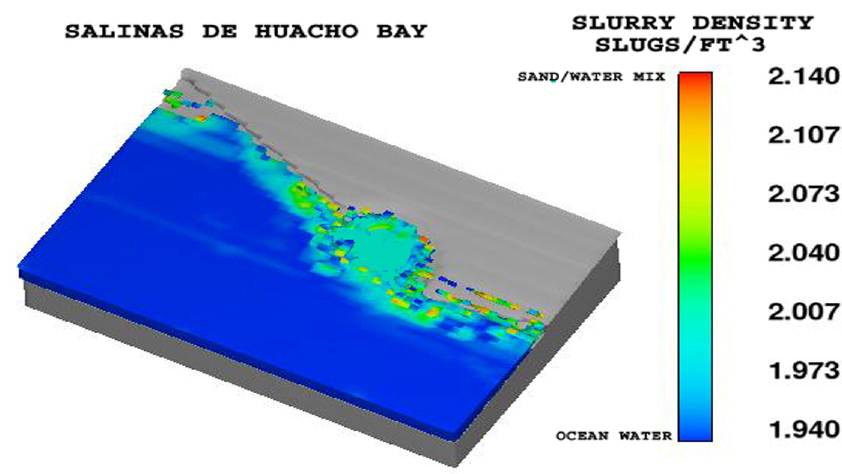
Figure 26. Later El Niño flood events creating a deposition sediment area behind an established beach ridge; the infilling phenomenon infills bays and creates marsh areas behind previously established beach ridges as well as extensions of previous shorelines, as the Figure 26 CFD model demonstrates.